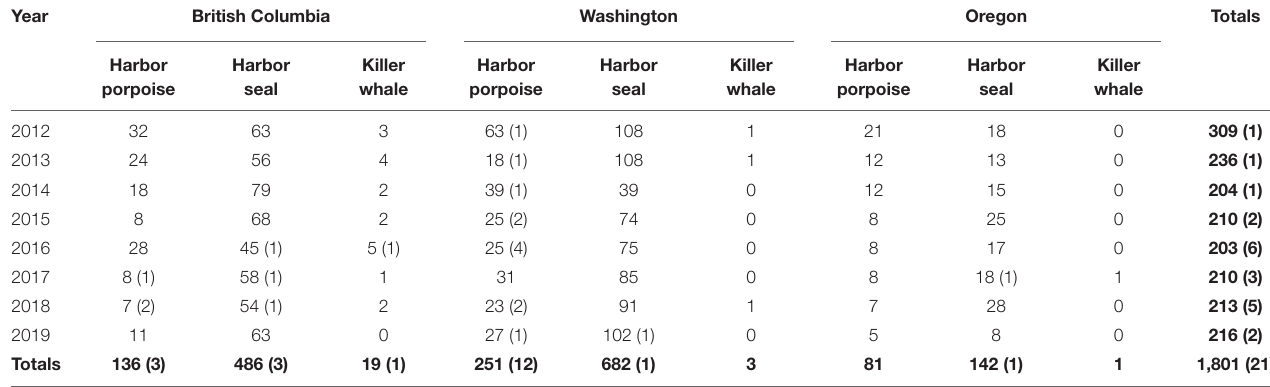
TABLE 1 | Necropsies conducted and mucormycosis cases (in parentheses) in the Pacific Northwest, 2012–2019, by year and